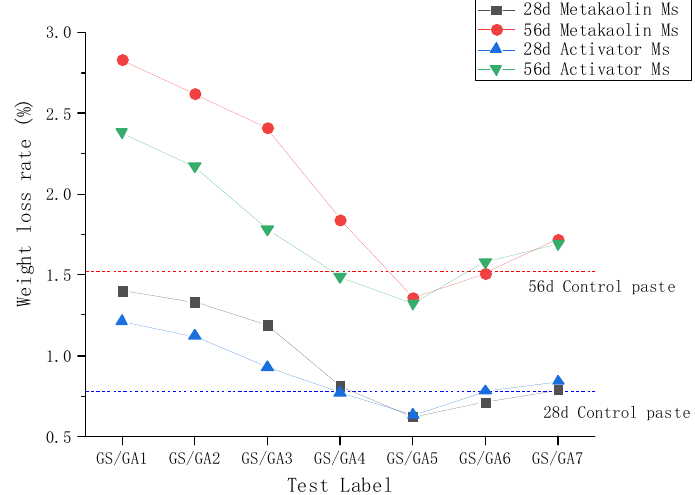
Figure 4. Weight loss rates of GS/GA and cement control pastes.